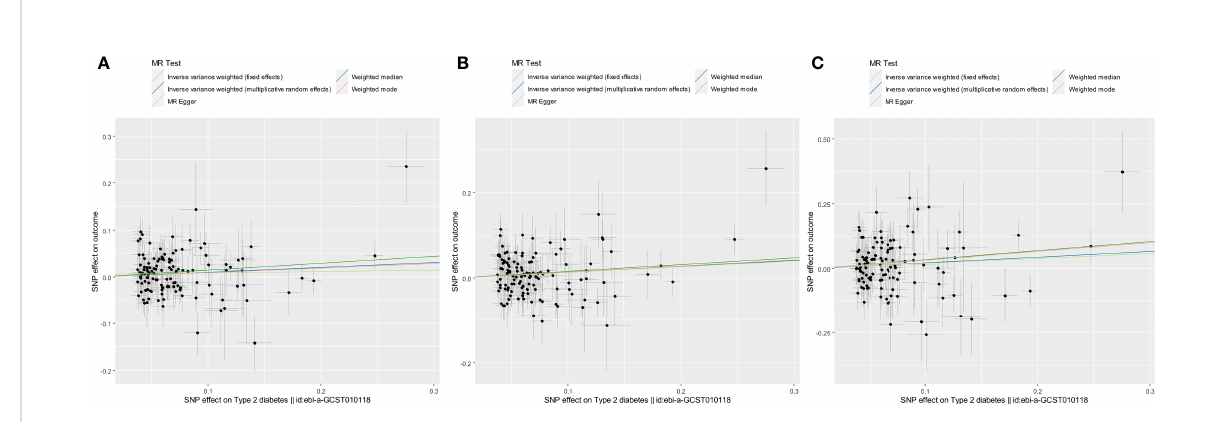
FIGURE 1 Scatter plots for estimating the causal effects of genetically predicted T2DM risk on the risk of COVID-19 susceptibility (A) , hospitalization (B) , and severity (C) . Each black point representing the size of the effect size of each SNP on the exposure (horizontal axis) and the outcome (vertical axis) is plotted with error bars corresponding to each SE. Each effect size is given as a log (OR) increase per allele. The slope of each line corresponds to the combined estimate using each method: the fi xed-effects IVW (light blue line), the multiplicative random-effects IVW (blue line), the MR-Egger regression (light green line), the weighted median (green line), and the weighted mode (red line). The slopes of the light blue line and the blue line were quite the same. Each OR was calculated by exponentiating each of the slopes. For example, the slope of the IVW line was 0.10, and the OR of COVID-19 susceptibility per log (OR) increase in T2DM was 1.11 (A)